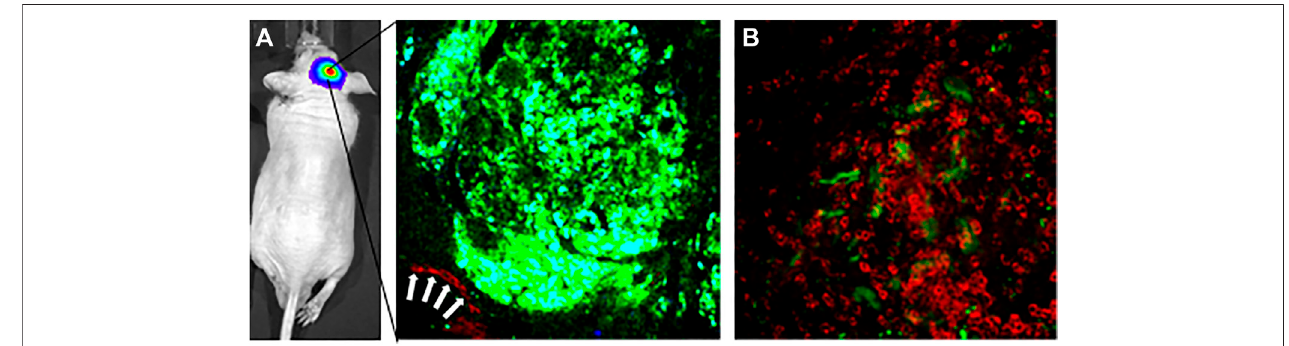
FIGURE 1 | Intravital multiphoton imaging demonstrates delivery of fl uorescent tumor-targeting liposomal nanoparticles across the blood-brain barrier to a glioma brain tumor in an intracranial orthotopic xenograft mouse model of glioma. (A) Left panel-intravital multiphoton image through a cranical window of a GFP-expressing glioma tumor. White arrows show Cy5.5-conjugated liposomal nanoparticles coursing throught a blood vessel adjacent to the tumor. Imaged immediately after tail vein injectionofnanoparticles. (B) Intravitalmutiphotonimagetaken24 hfollowingtailveininjectionshowingaccumulationofCy5.5-conjugatedliposomalnanoparticles on the surface of the brain tumor. Accumulation Cy5.5 signal in cells with a bulls-eye center suggestive of uptake of nanoparticles by resident brain